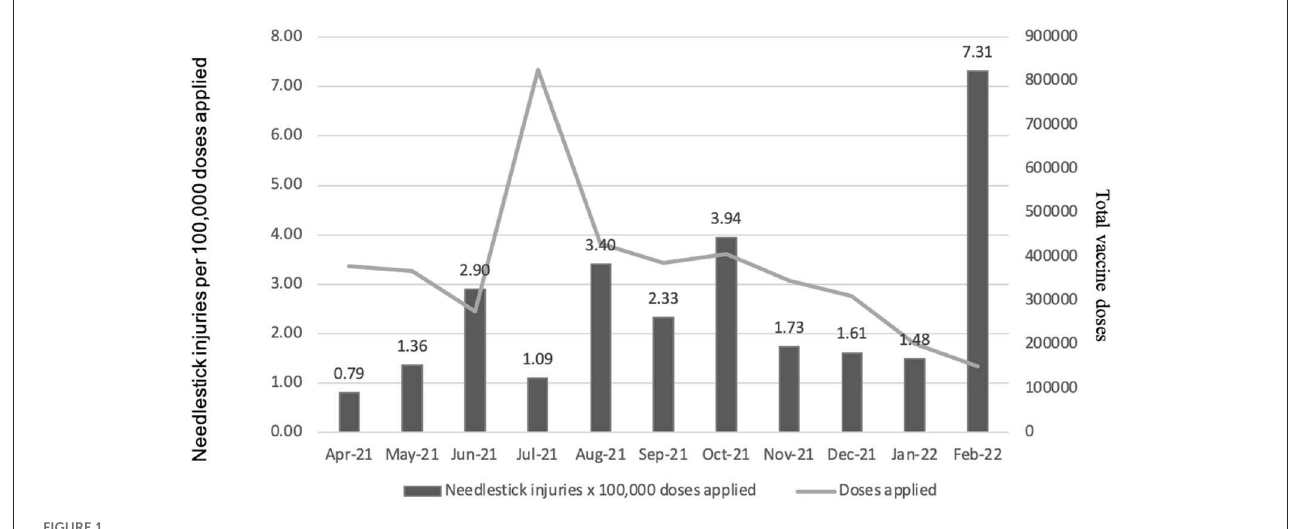
FIGURE1 Rate of needle stick injuries × 100,000 doses among healthcare